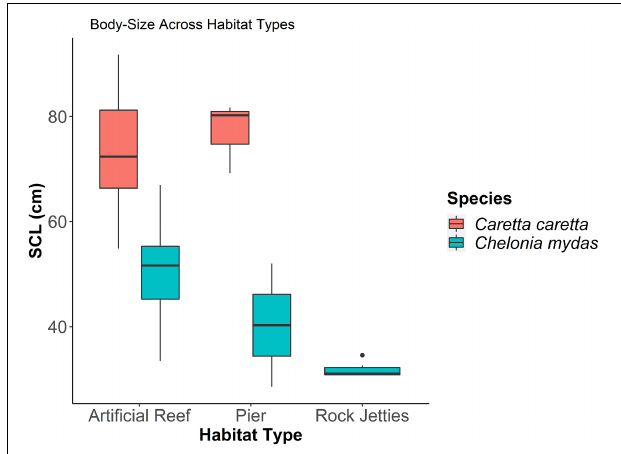
FIGURE 4 | Sea turtlestraight carapace length (SCL) in relation to habitat type and